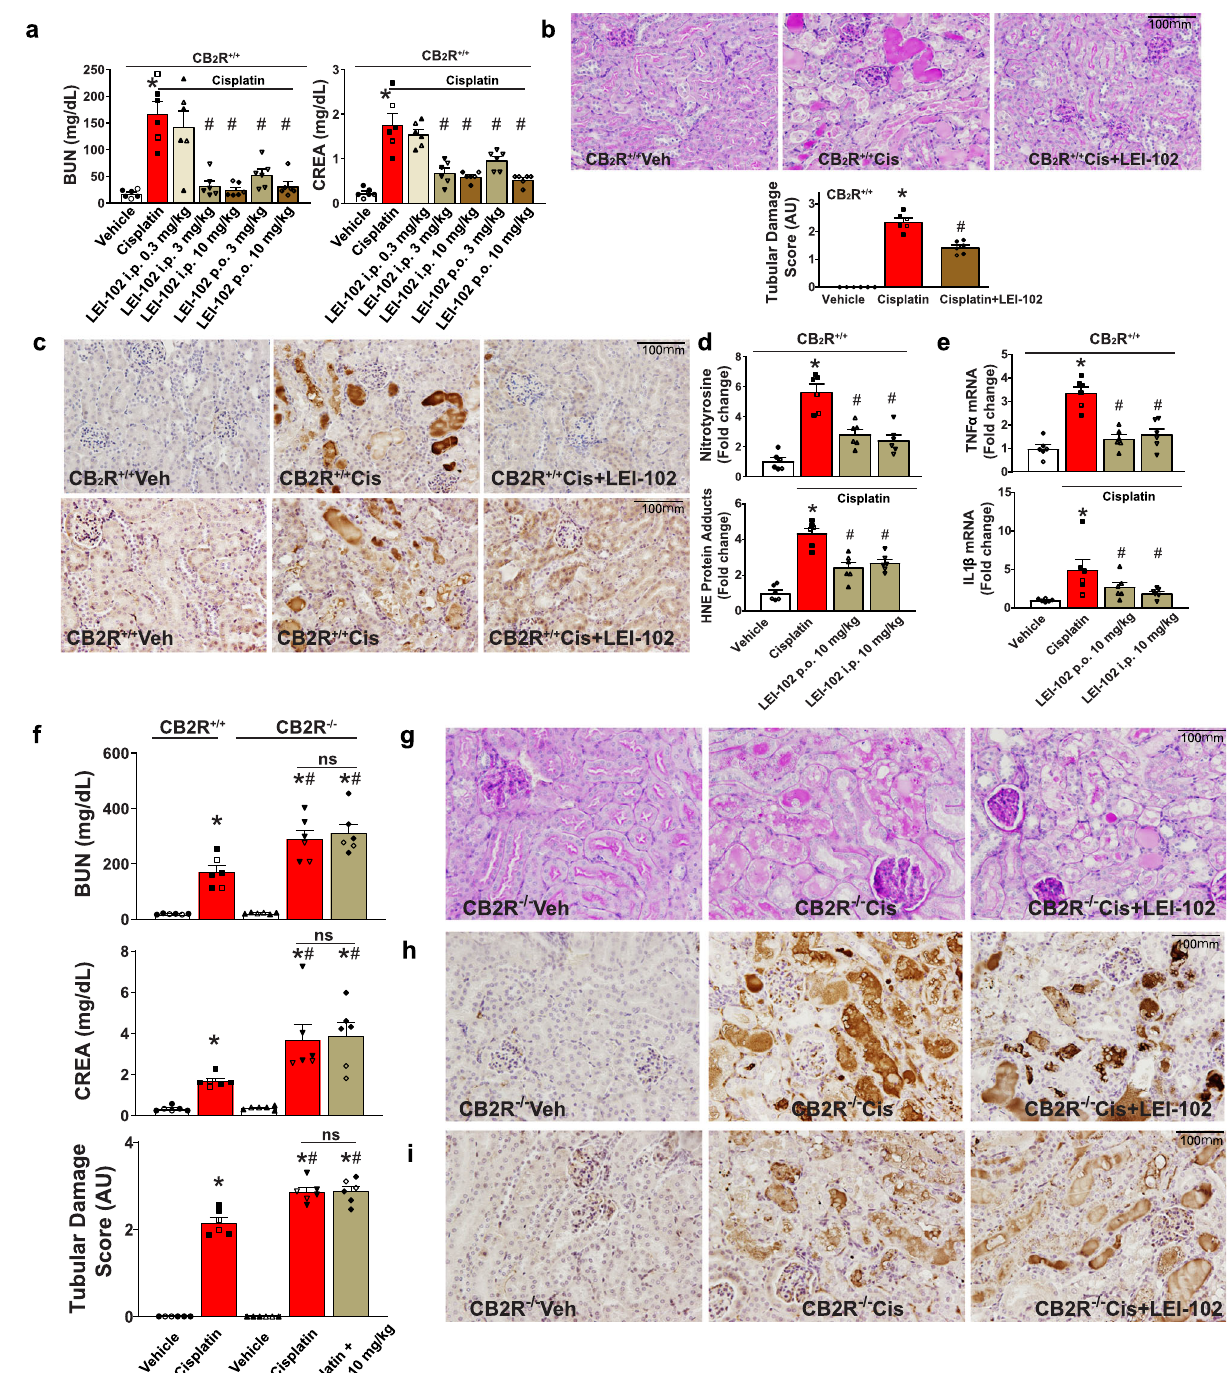
damage (Fig. 5f), histopathological injury (Fig. 5g) and markers of oxidative-nitrative stress (Fig. 5h, i) were abolished in CB 2 R